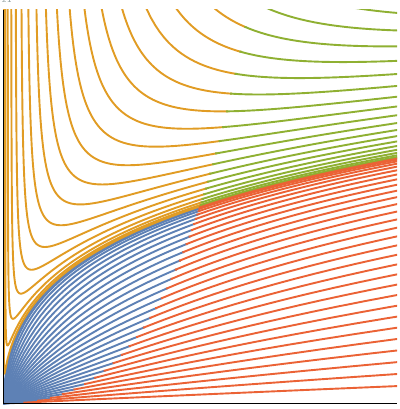
Figure 28 . Absolute values of boundary distances u 12 and u 21 as functions of angles (cid:11) 1 ; (cid:11) 2 . Blue region corresponds to real angles, green to imaginary angles, and yellow and red to one angle being real and one